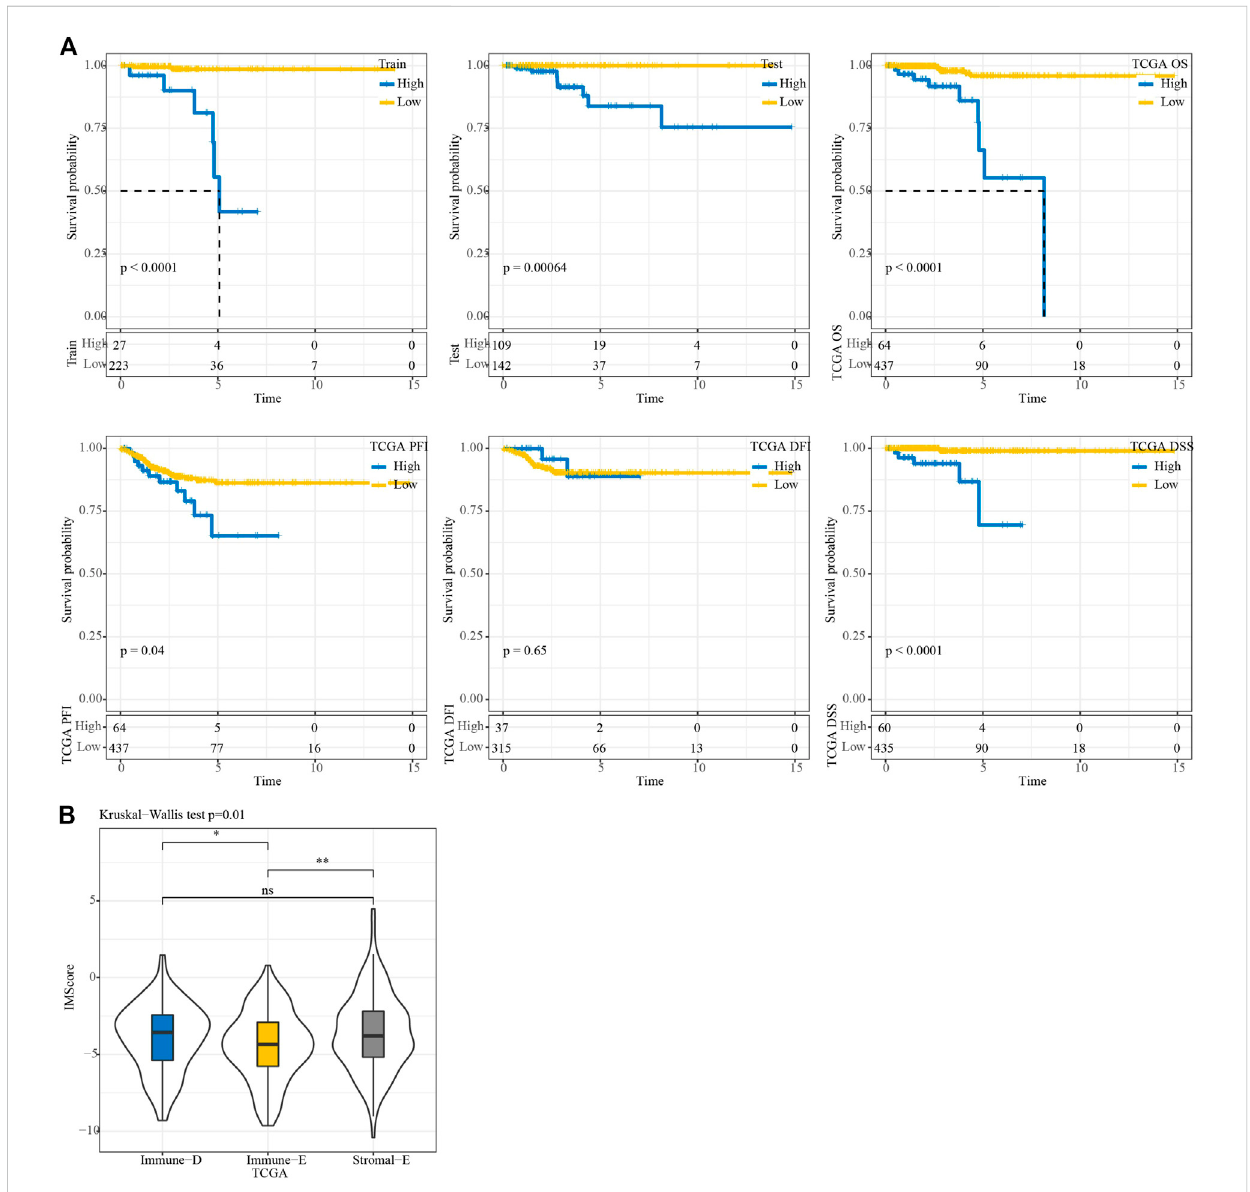
FIGURE 8 KMsurvivalanalysis. (A) KMsurvivalanalysisofthehighandlowgroupsinTCGAtrain,test,entire,TCGA-PFI,TCGA-DFI, andTCGA-DSSdatasets. (B) Differences in IMScore among the three molecular